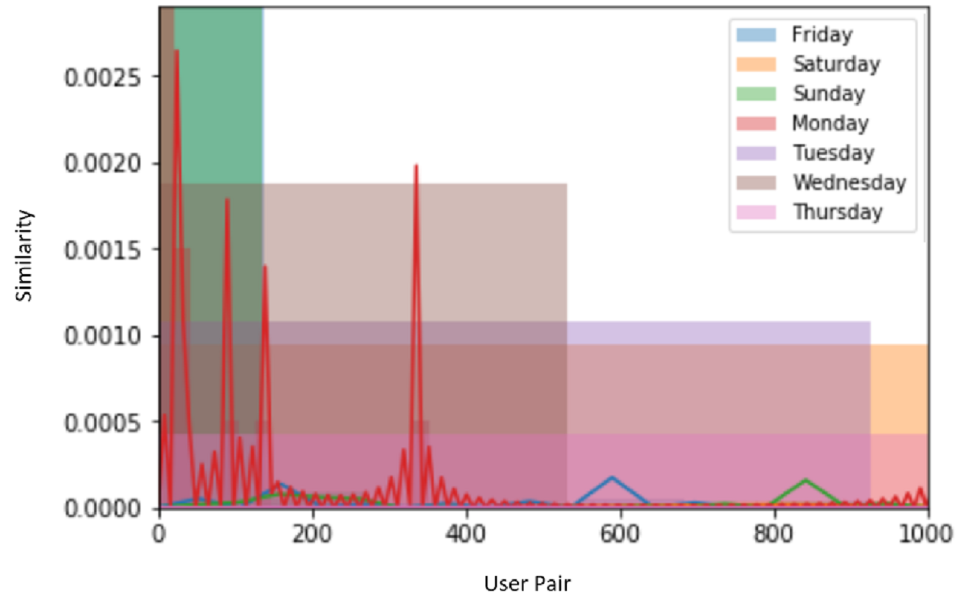
Figure 4. Similarity analysis of all 7 days of a